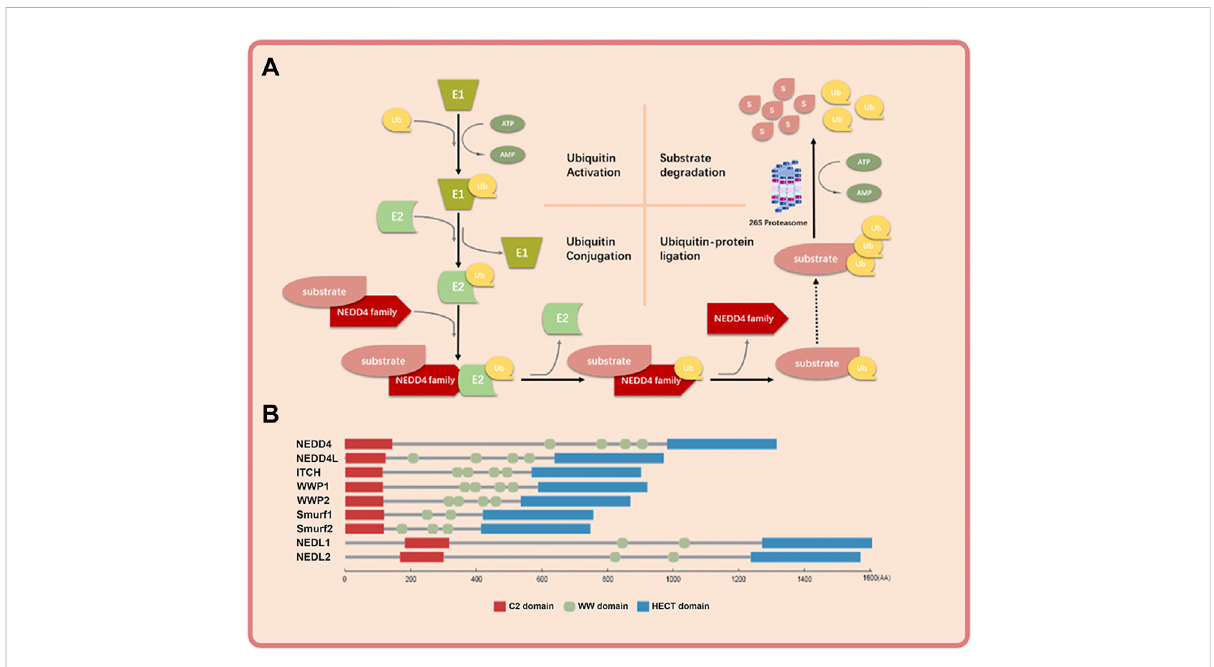
FIGURE 1 ThebasicmechanismofNEDD4familyinubiquitin-proteosomesystemandtheschematicstructureofNEDD4familymembers. (A) Ubiquitinis activated by ubiquitin activating enzyme (E1), transferred by ubiquitin conjugation enzyme (E2) to NEDD4 family (E3), and covalently bound to substrate protein by NEDD4 family. The polyubiquitinated substrate protein is recognized and degraded by 26s proteosome fi nally. (B) The NEDD4 family gene mainly has three functional domains: C2 domain, where the amino terminus can bind to cell membrane, WW domain, which is the central region of protein-protein interaction, and HECT domain, where the carboxyl terminus has ubiquitin-protein